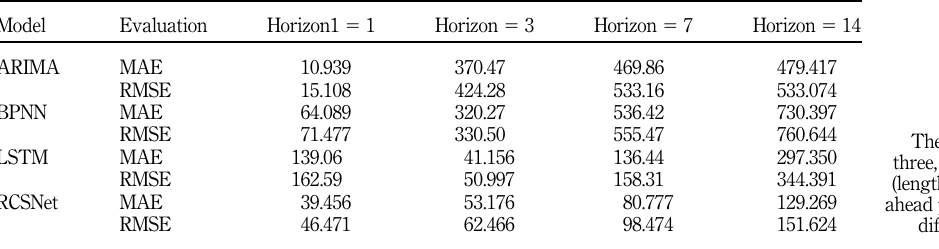
Table 1. The results of one, three, seven, 14 days (length of time steps) ahead prediction with different